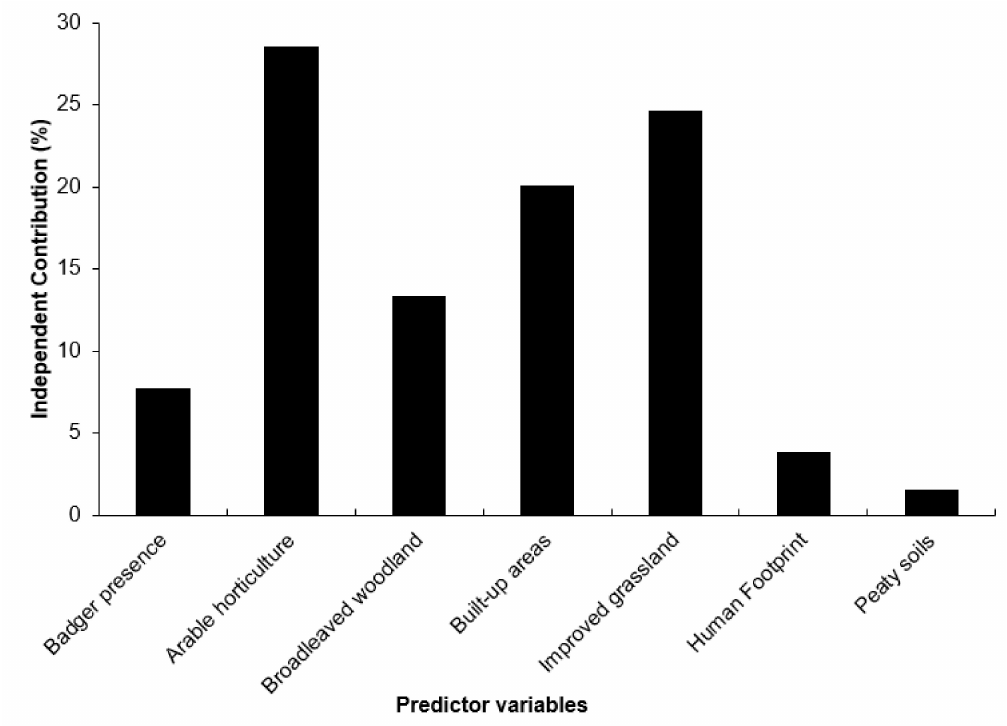
Figure 6. Results of hierarchical partitioning showing the individual contribution of each variable towards the total explained variation (R 2 ) of the model (R 2 =